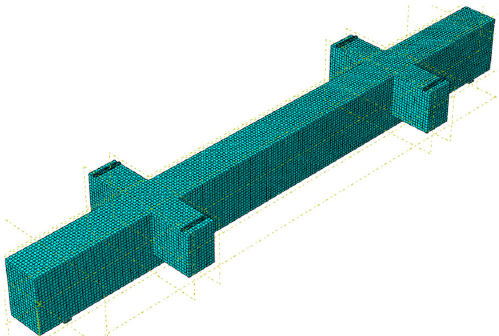
Figure 11. The FE model of the beam under indirect loading.